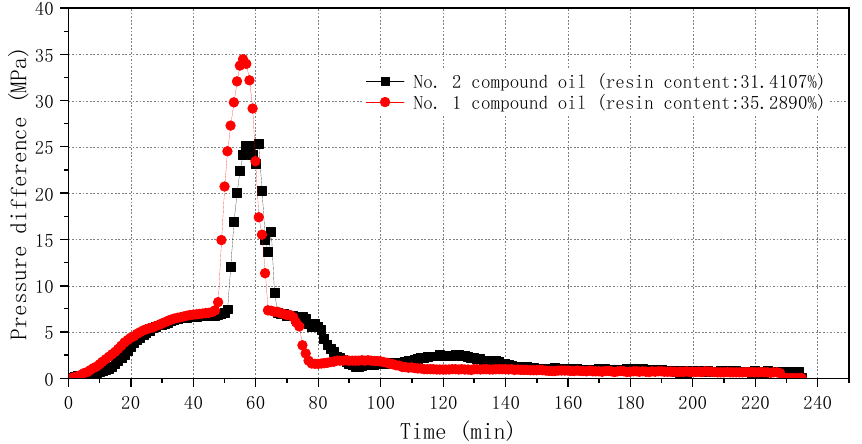
Figure 1. Displacement pressure of two different compound oil.